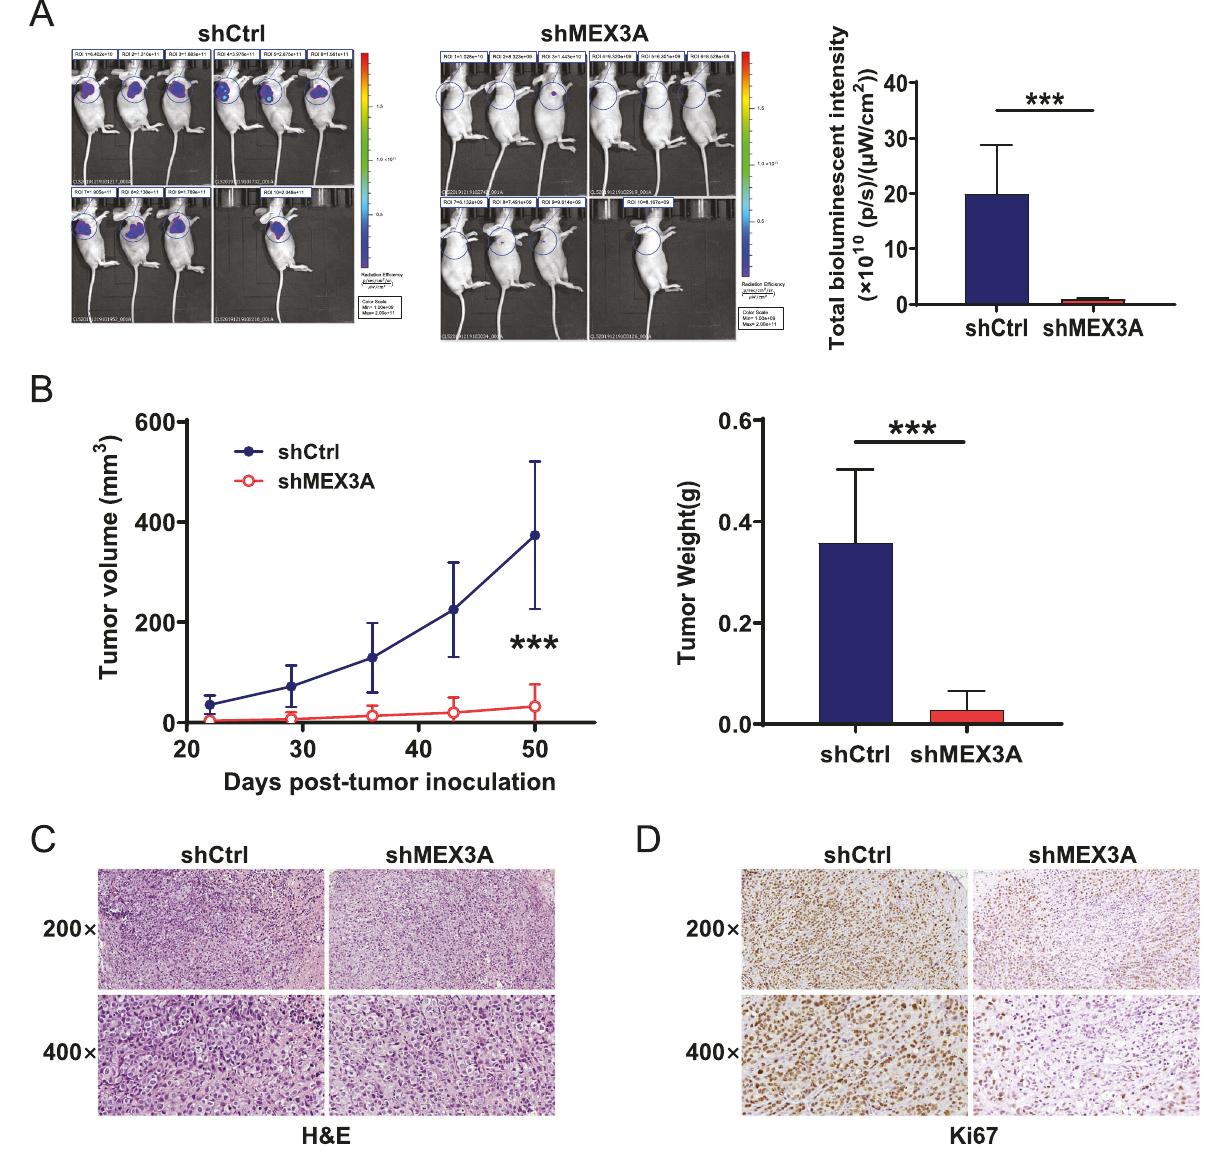
Fig. 3 MEX3A knockdown suppresses tumorigenesis of NPC in vivo. A The fl uorescence intensity of xenograft tumors was observed through injection of D-luciferin before sacri fi cing mice at the study endpoint. B Tumor volumes were calculated at the indicated days after tumor inoculation. C , D Representative images of H&E ( C ) and Ki-67 protein ( D ) staining of xenograft tumors from both groups. Magni fi cation: 200× or 400×. *** P <